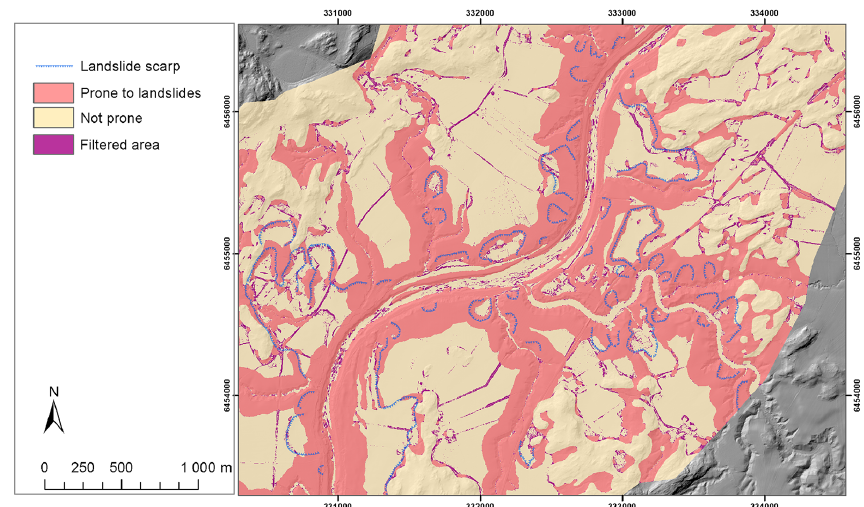
Figure 5. Map of area prone to landslides obtained using 1 : 10 as cross-sectional angle thresholds for the best-case scenario soil class. The filtered areas were removed by using the following filtering parameters: double pre-filtering with 5-pixel neck size, elevation difference equal to 5m, and minimal area threshold equal to 6 pixels.